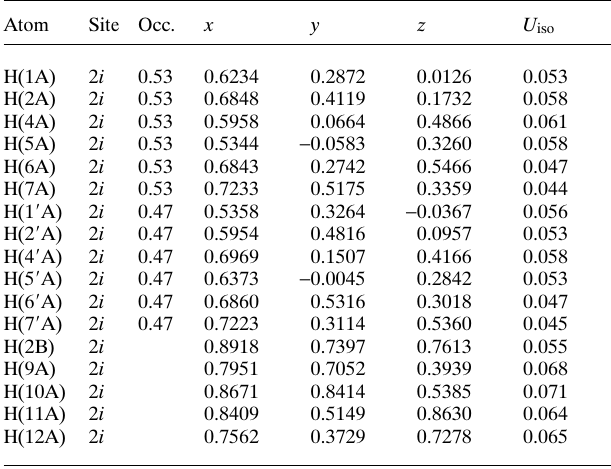
Table 2. Atomic coordinates and displacement parameters (in Å 2 ) . Table 1. Data collection and